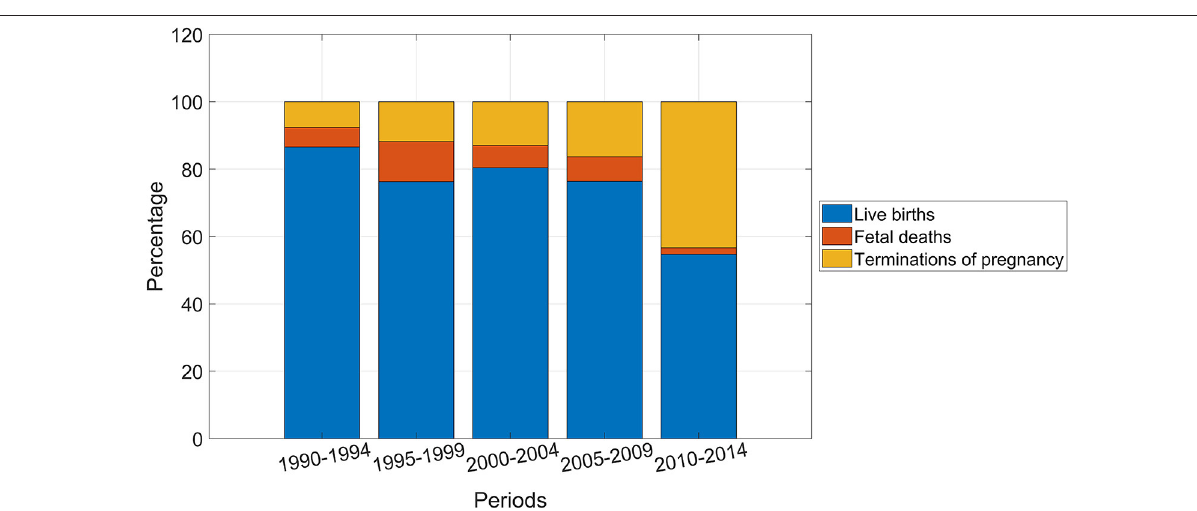
The distribution of the pregnancy outcomes in 5 year